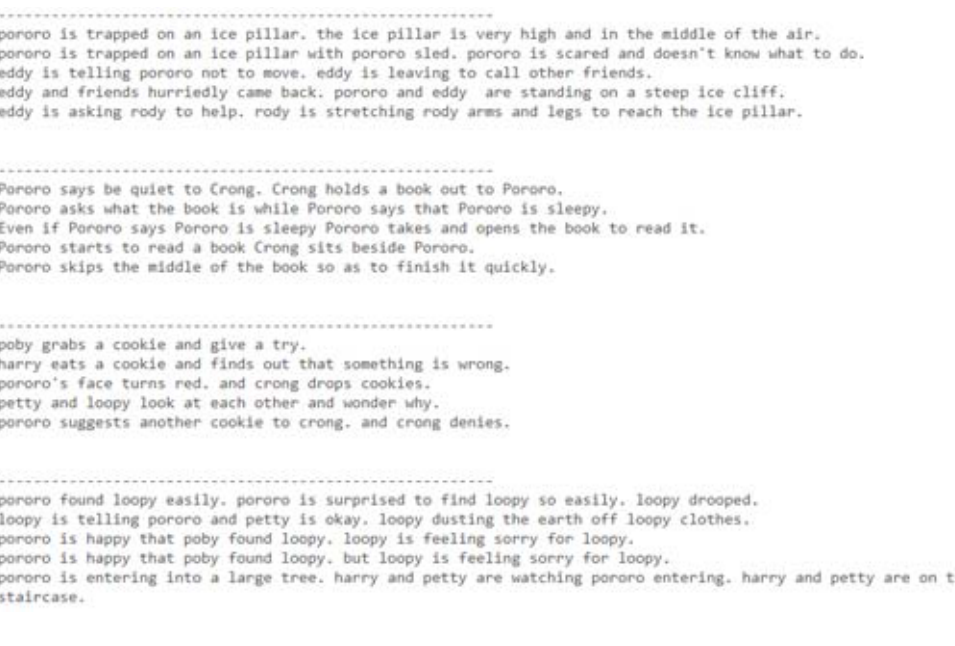
Fig. 4.5. Generated Story.